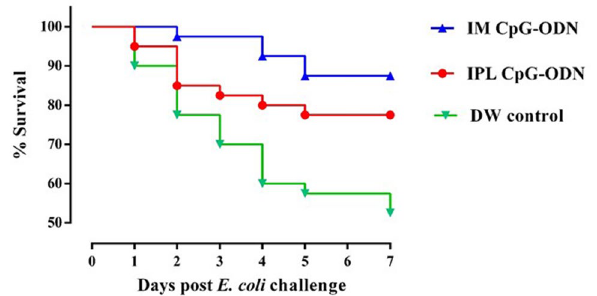
Figure 1. Survival percentages of the birds following lethal E. coli infection. Day-old neonatal chicks were treated with 50 µg of CpG-ODN intramuscularly (IM) or mucosal delivery via intrapulmonary (IPL) route [6 mg CpG-ODN aerosolized in a closed 0.036 m 3 acrylic chamber containing 60 birds for 30 min] or treated with aerosolized distilled water (DW) as control. On the second-day post-treatment, the birds in each group (n = 40) were challenged with 1 × 10 5 CFU or 1 × 10 6 CFU of E. coli per bird, subcutaneously in the neck. The mortality was recorded until seven days post-challenge. Birds that received IM CpG-ODN (blue) and IPL CpG- ODN (red) treatments showed significantly better survival than the DW control (green) group ( P < 0.05) over seven days post